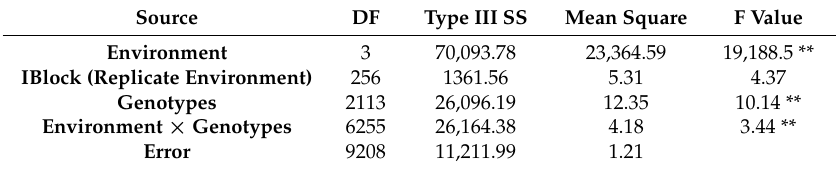
Table 1. Analysis of variance for grain protein content (GPC) of the 2111 genotypes across environments.